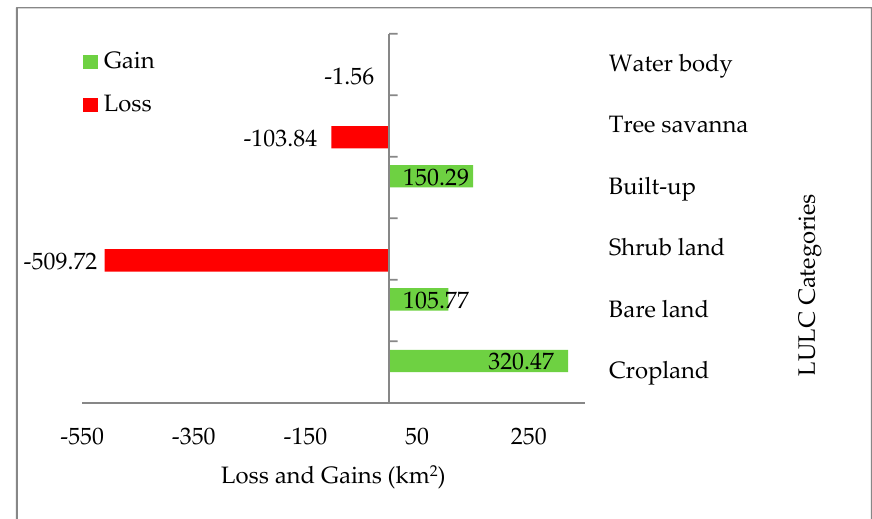
Figure 10. Transition change matrix from 2015–2035 (km 2 ) (losses and gains).